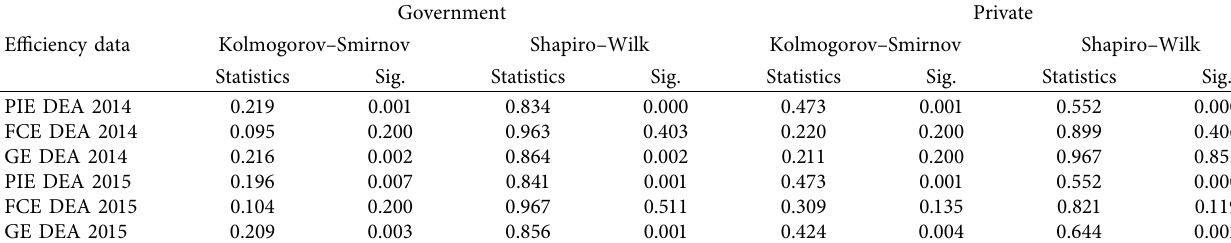
Table 5: Normality tests for DEA efficiency